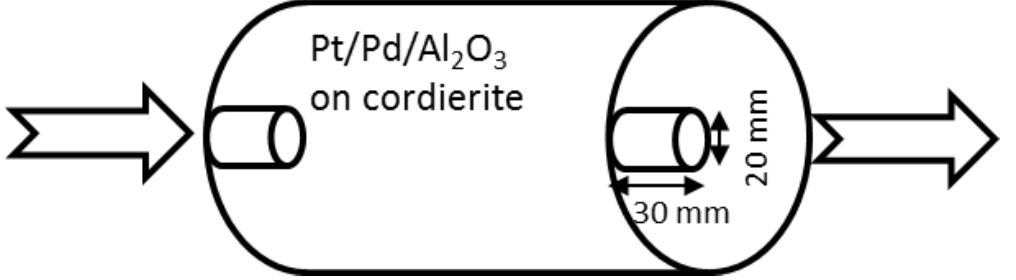
Figure 8. Cylindrical catalyst samples were taken from the front and the rear of the vehicle-aged catalyst.